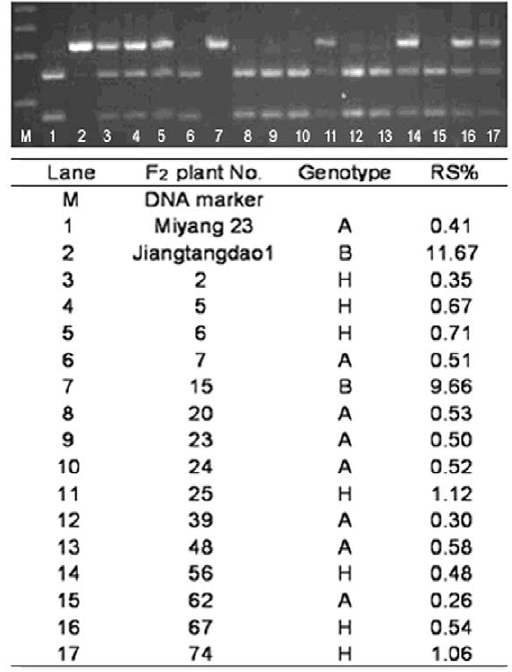
Figure 7. Verification of the CAPS marker using a part of F 2